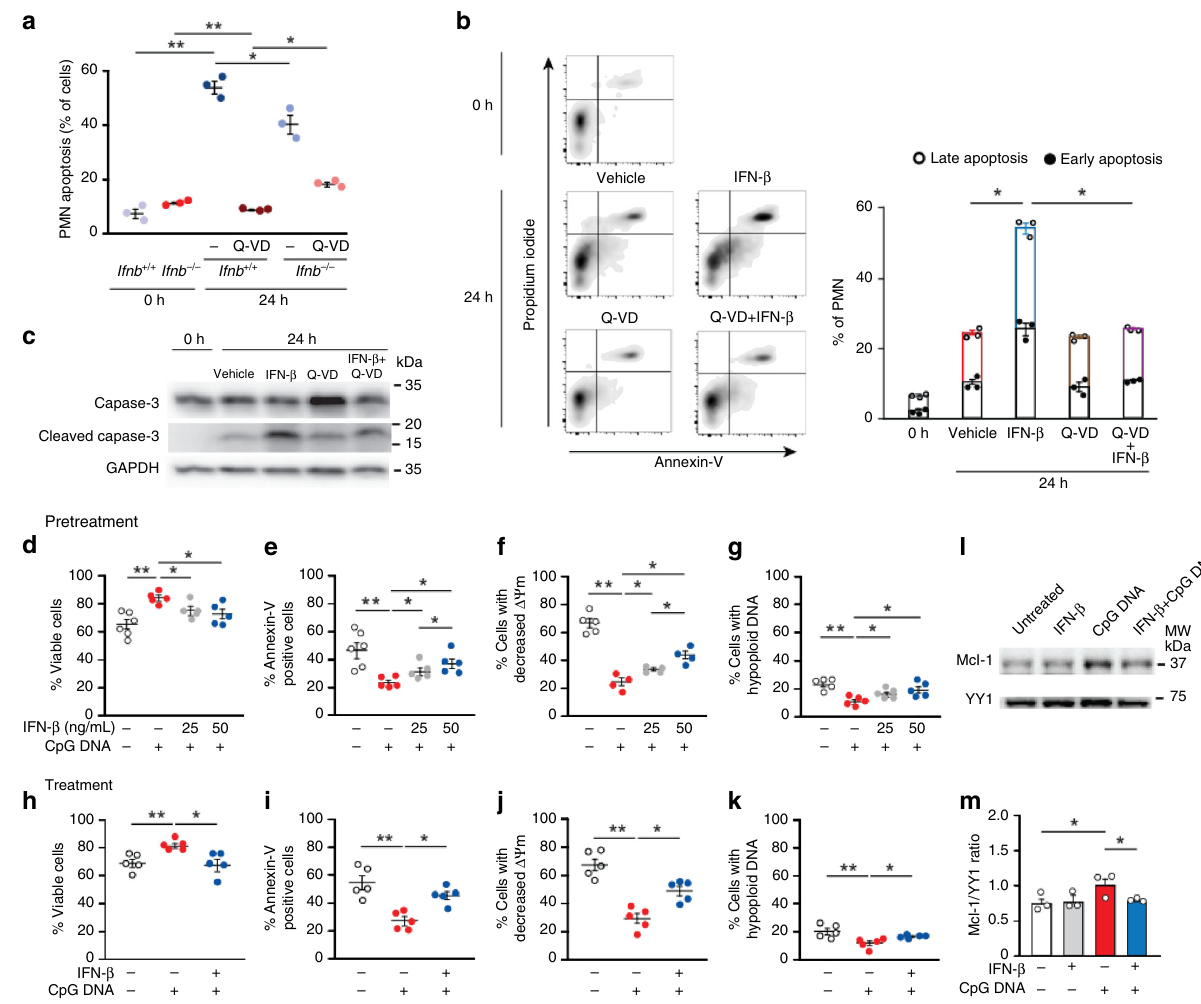
Fig. 4 IFN- β promotes apoptosis in mouse and human neutrophils. a Peritoneal PMN were recovered from male Ifnb + / + or Ifnb − / − mice at 4 h PPI and stained immediately with annexin-V and propidium iodide to assess apoptosis and cell viability, respectively with fl ow cytometry. Alternatively, cells were cultured with or without the pan-caspase inhibitor Q-VD (10 μ M) for 24 h and then assessed for apoptosis. Results are mean ± SEM from three independent experiments. * P < 0.05, ** P < 0.01 (Tukey ’ s HSD). b , c Peritoneal PMN were recovered from Ifnb + / + mice 24 h PPI and cultured ex vivo with IFN- β (20 ng/ml) and/or Q-VD (10 µ M) for 24 h. Apoptosis was evaluated as above. In some experiments, PMN lysates were prepared after 6 h culture and immunoblotted for cleaved (active) caspase-3. Results are representatives for three independent experiments. * P < 0.05 (Tukey ’ s HSD). d – g Human PMN (5 × 10 6 cells/ml) were pretreated with human recombinant IFN- β (25 – 50 ng/ml) for 10 min and then challenged with CpG DNA (1.6 μ g/ml)